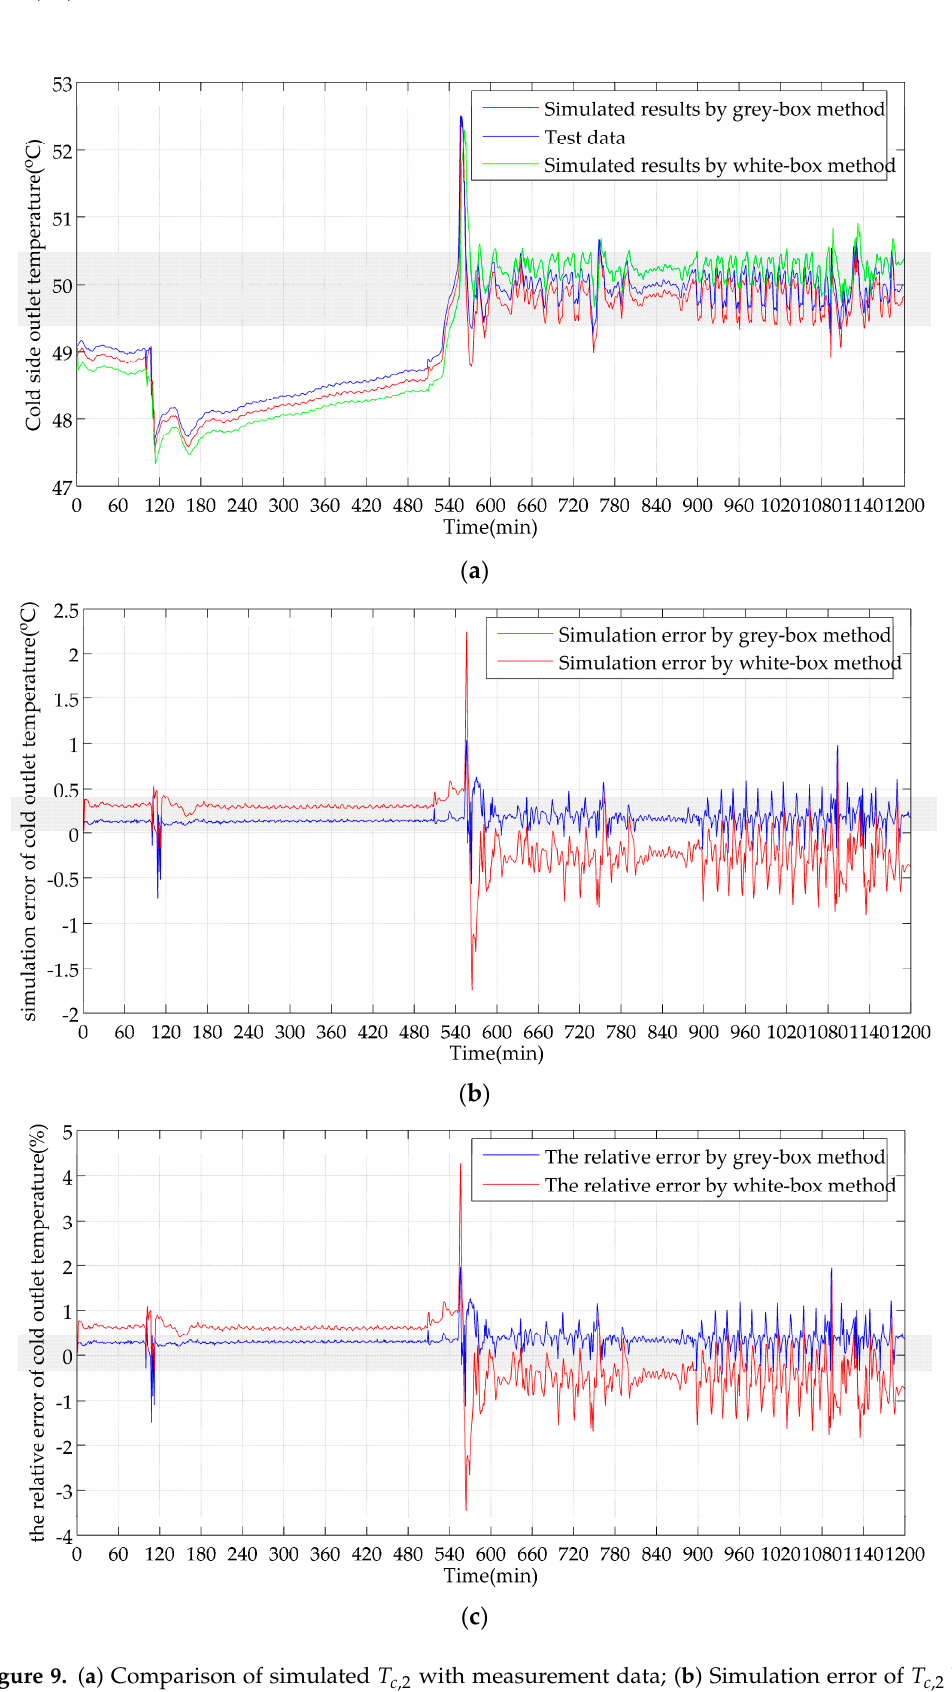
Figure 9. ( a ) Comparison of simulated T c ,2 with measurement data; ( b ) Simulation error of T c ,2 by white-box and grey-box method; ( c ) The relative error of T c ,2 by white-box and grey-box method.